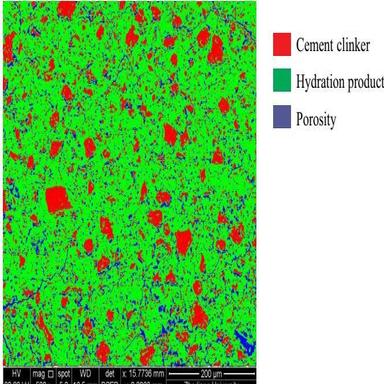
Typical BSE image of three-phase microstructure of the HCP specimen.